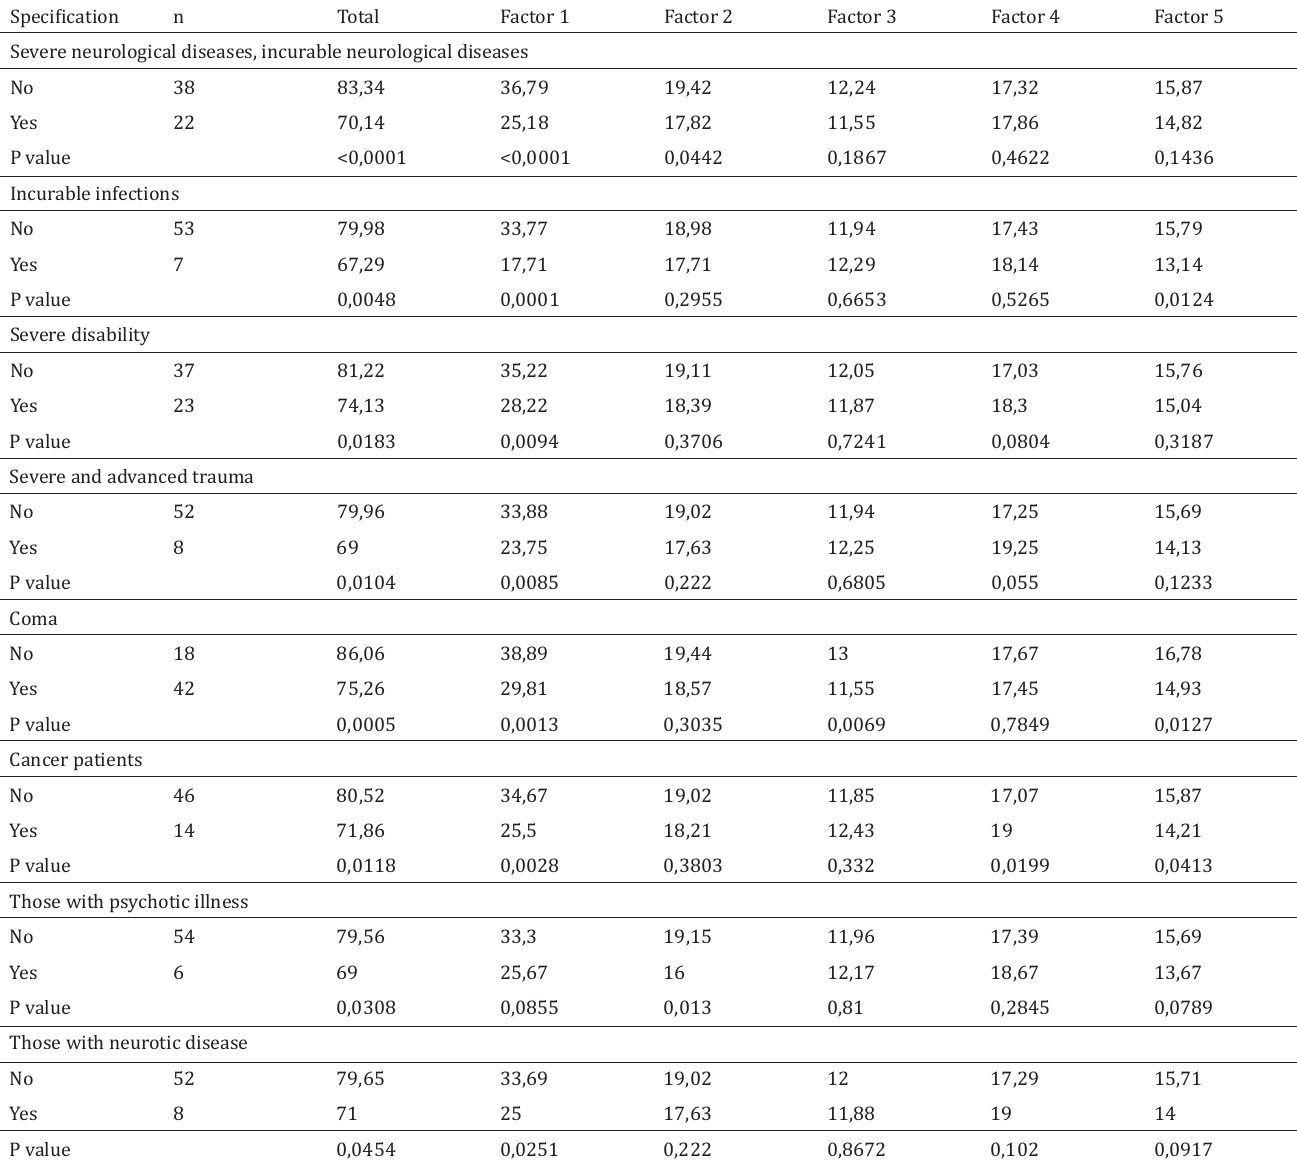
Comparison of attitude scale scores and factor scores regarding euthanasia, death, and the terminally patient according to diseases.